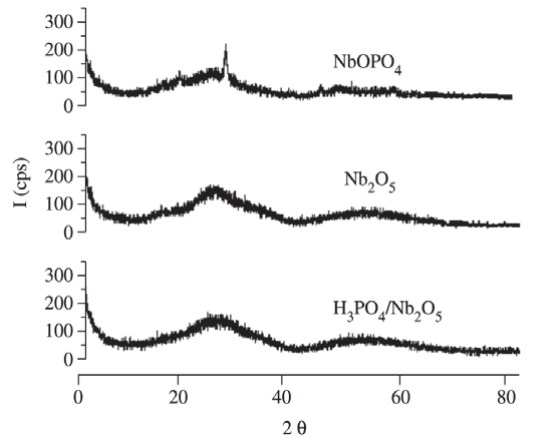
Figure 4. X-ray diffraction patterns of the samples.